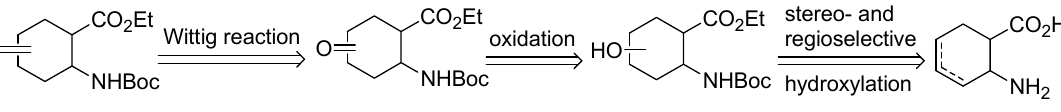
Figure 1. Some biologically interesting cyclic β -amino